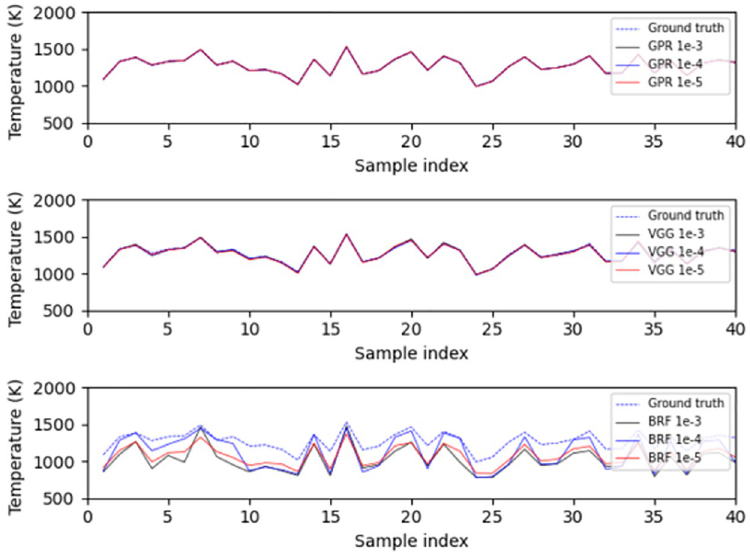
Fig 10. Examples of generalization performance of the retrained models on ten-section-profile spectra.